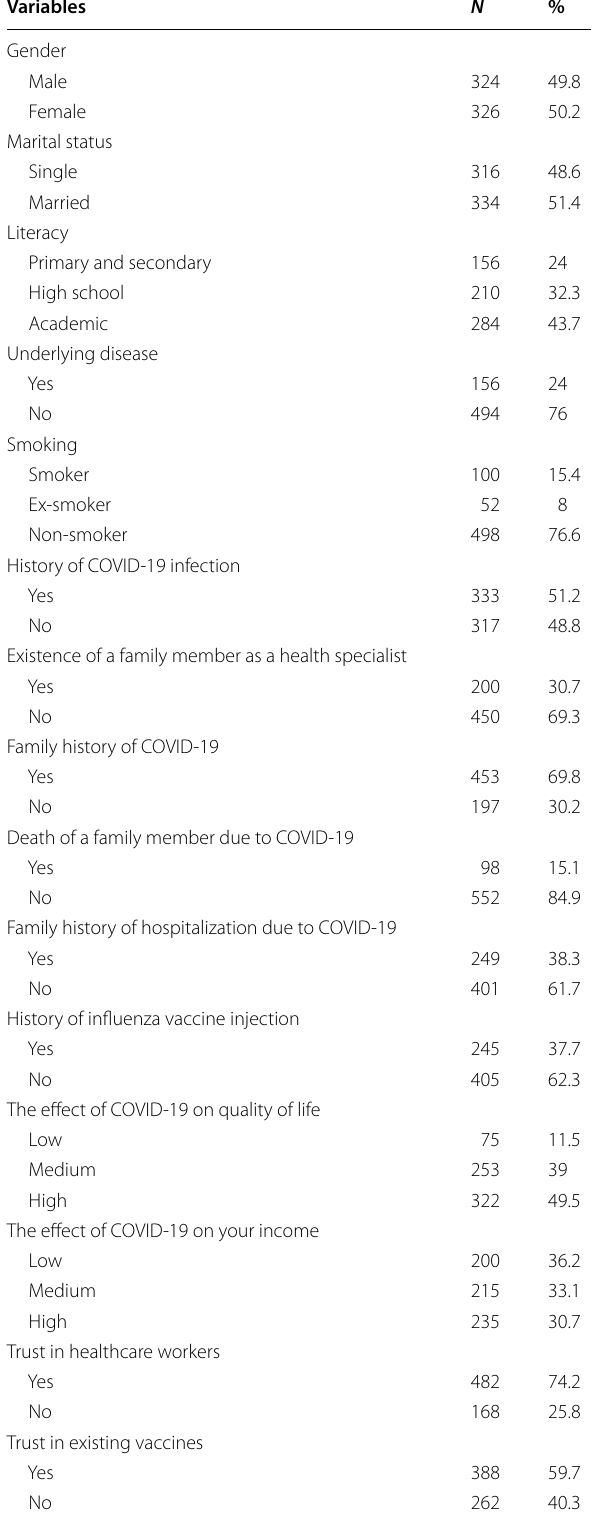
Table 1 The demographic profile of the study